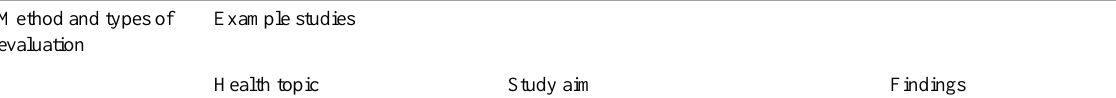
Table 1. Examples of evaluations of commercial mobile health apps. Example studiesMethod and types